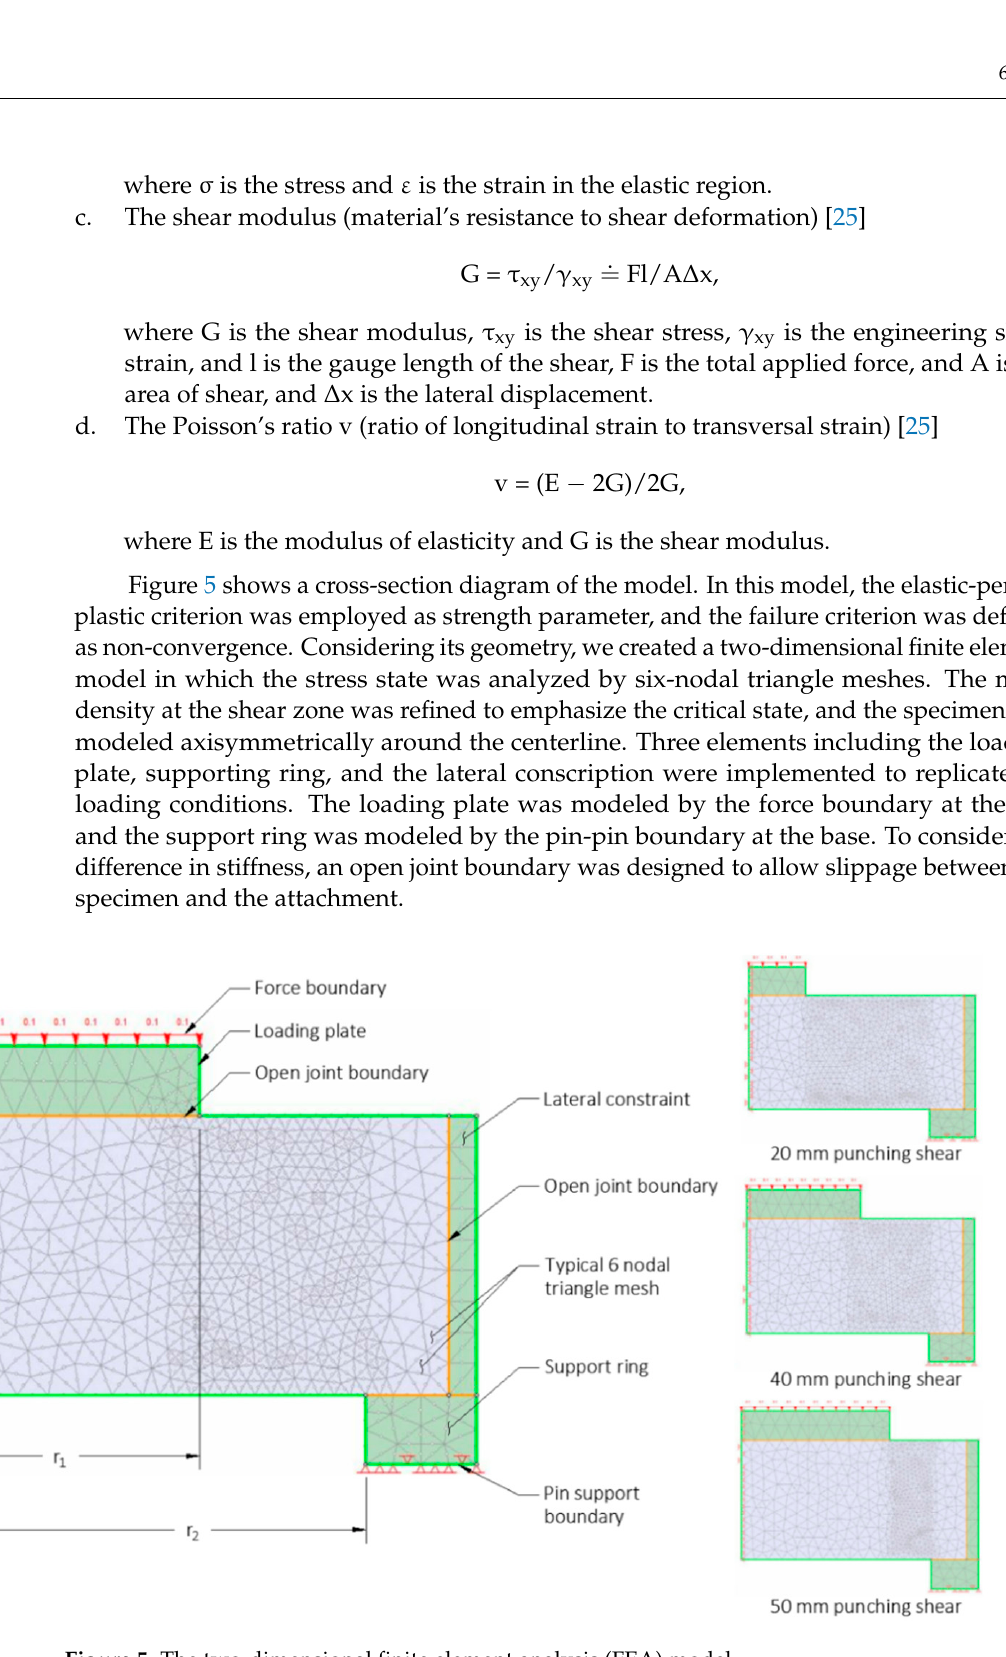
Figure 5. The two-dimensional finite element analysis (FEA) model.